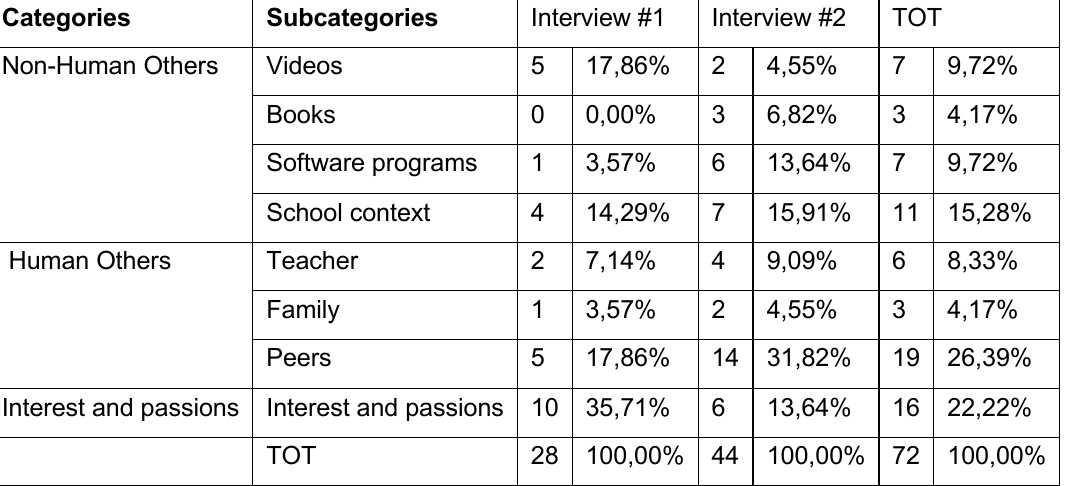
Table 2: frequencies of categories and